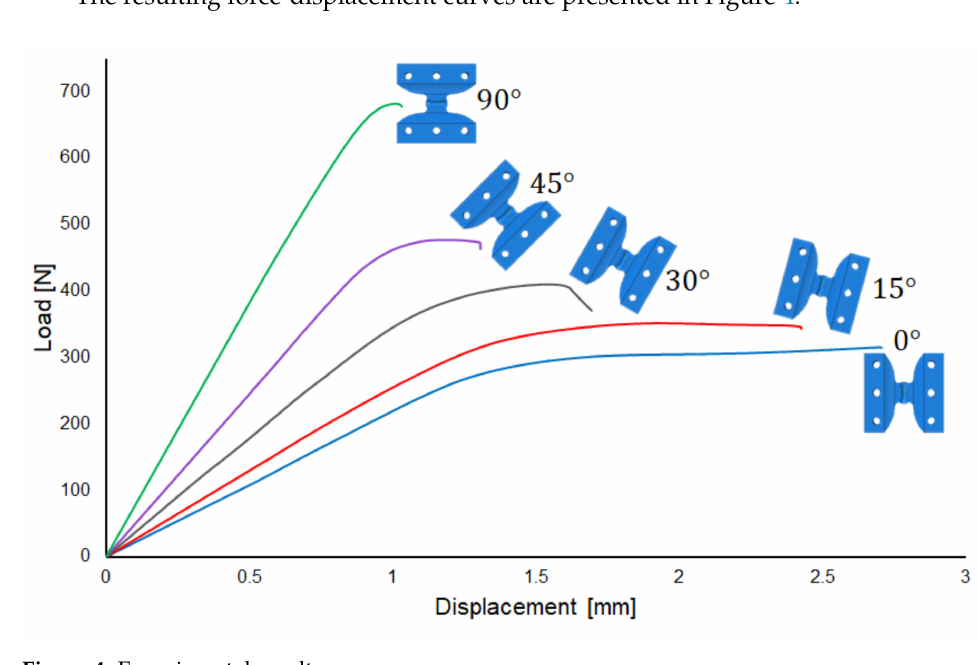
Figure 4. Experimental